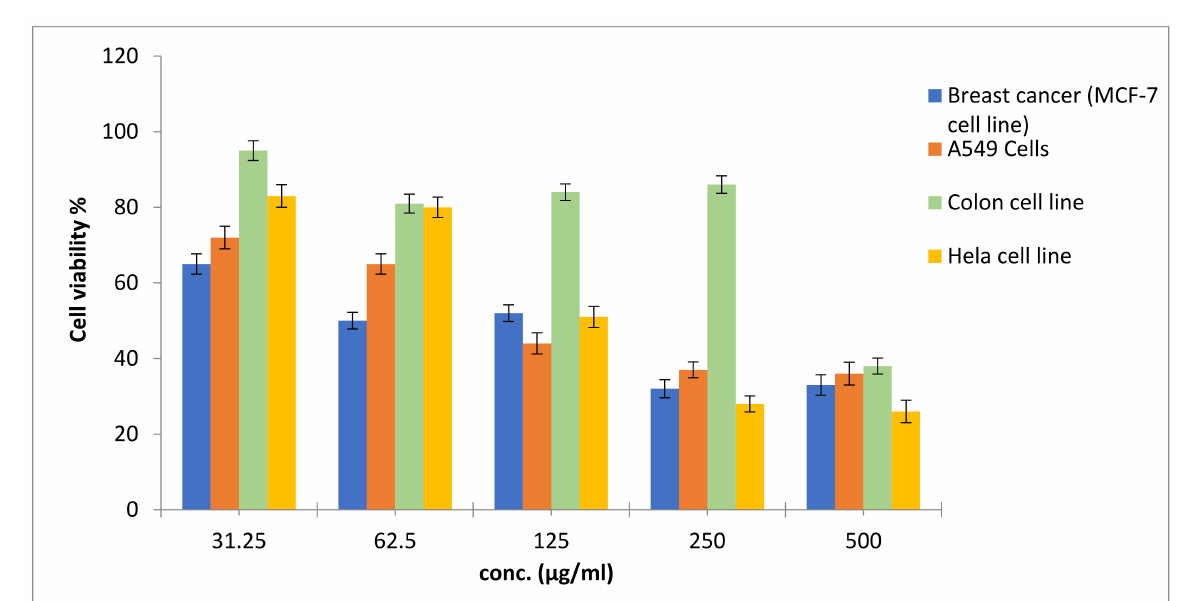
Figure 2. Anticancer activity of the tested extract (0.44 mg/L Zn of Nostoc linckia ) against four cell lines.